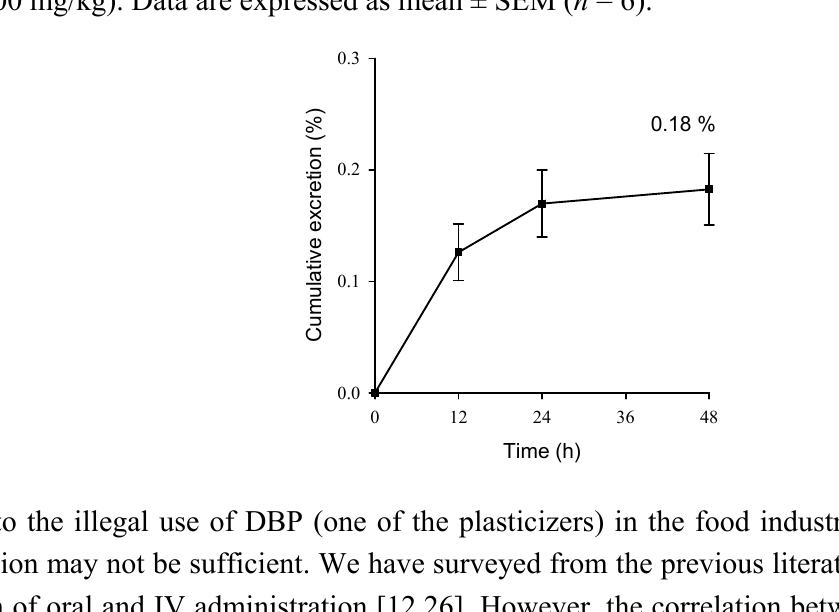
Figure 5. Cumulative excretion of DBP in feces after oral administration of DBP (100 mg/kg). Data are expressed as mean ± SEM ( n =